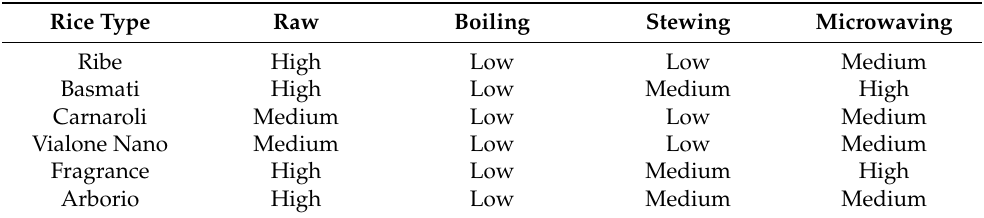
Table 7. Rice classification depending on amylose content of the six analyzed rice varieties as raw and after the application of the three considered cooking methods (according to Suwannaporn et al. classification for raw